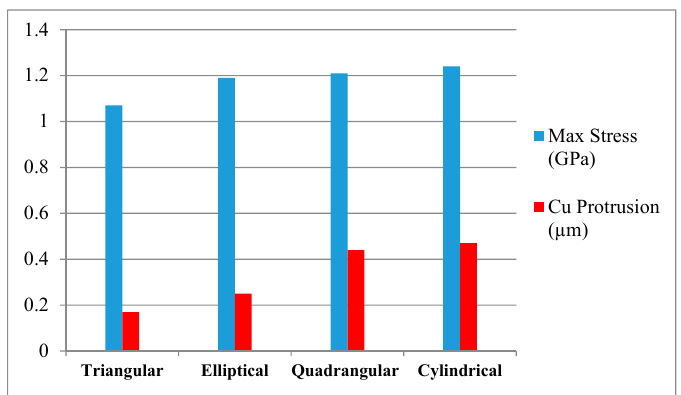
Figure 11. Cu protrusions and max induced stress in Si for different TSV shapes at 450 °C.